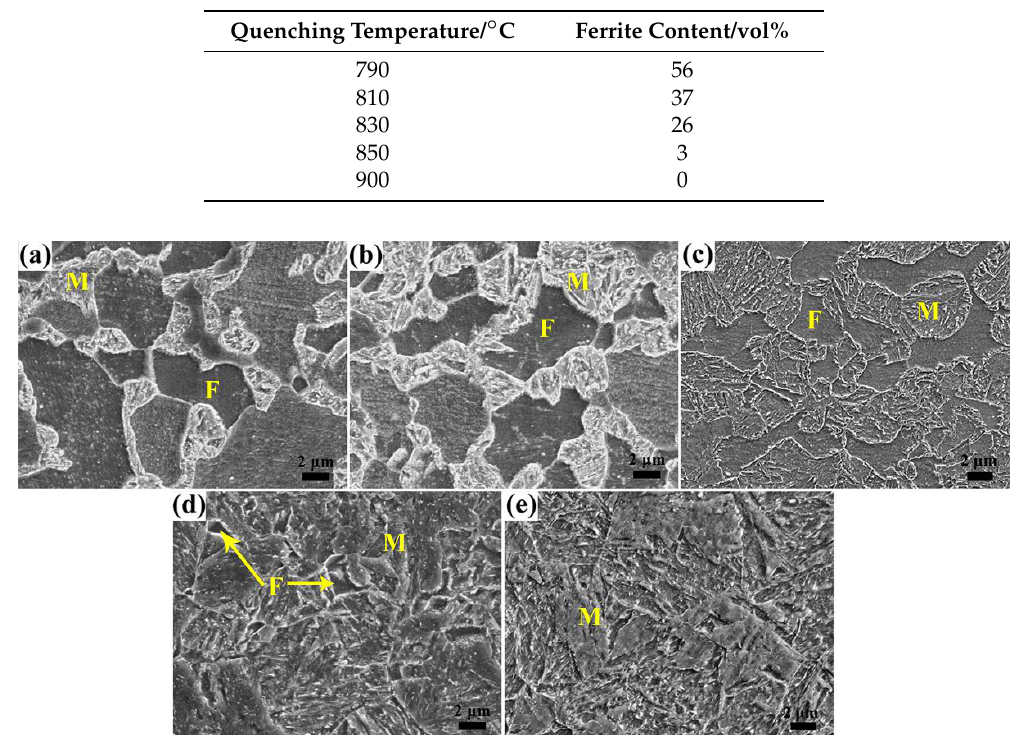
Figure 2. SEM microstructure of HSLA steel quenched from ( a ) 790 °C, ( b ) 810 °C, ( c ) 830 °C, ( d ) 850 °C, and ( e ) 900 °C, and tempered at 450 °C.